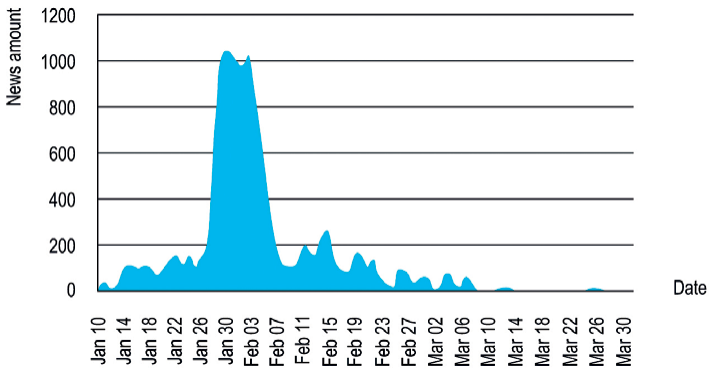
Fig 3. The distribution of the